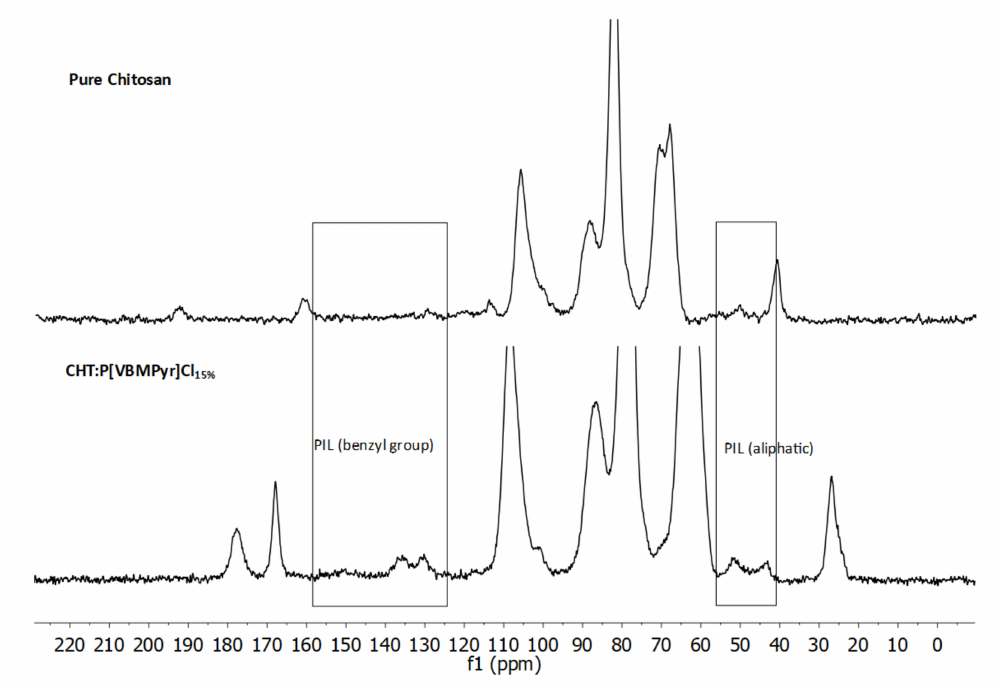
Figure 4. 13 C CP-TOSS NMR spectra of pure chitosan and CHT:P[VBMPyr]Cl 15% beads, respectively.